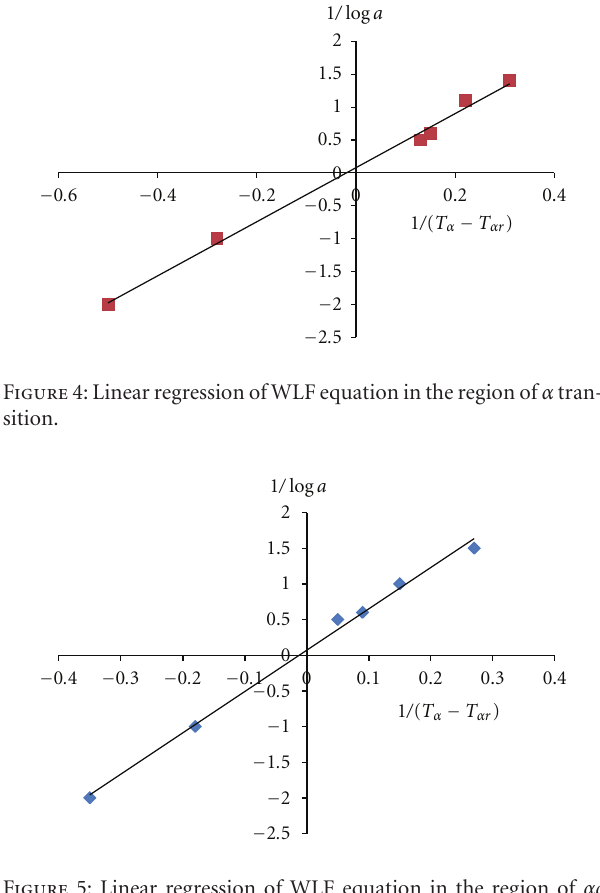
Figure 5: Linear regression of WLF equation in the region of α c transition.